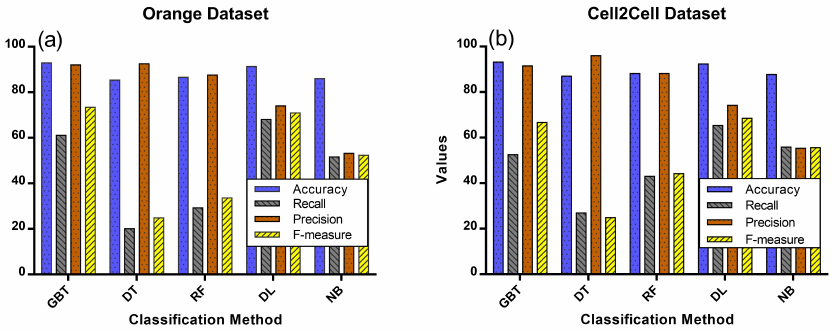
Figure 3. ( a ) Results analysis using single classification methods on the Orange dataset. ( b ) Results analysis using single classification methods on Cell2Cell